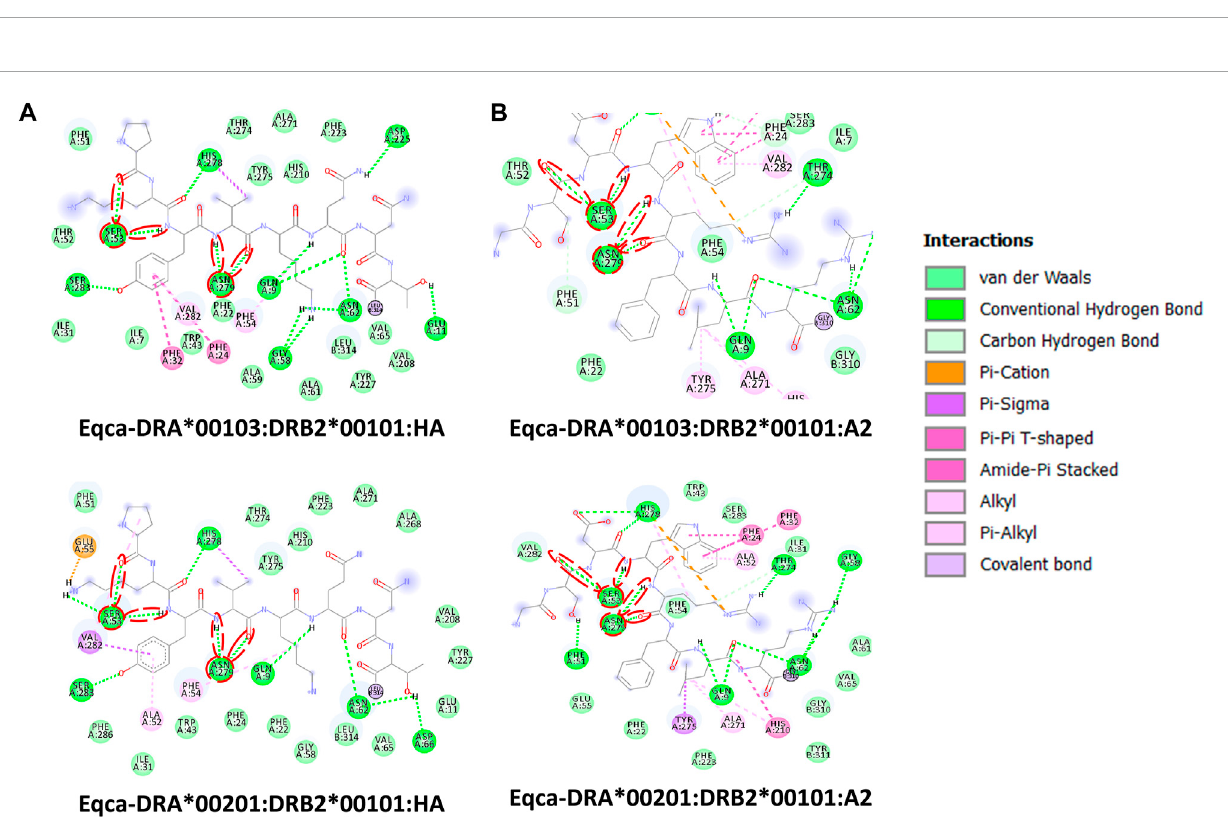
FIGURE 4 Molecular interactive illustration showing the interaction of redocked standard ligands with homology models of the two allelic Eqca-DR. (A) hemagglutinin (HA) and (B) endogenous peptide A2 (A2). 2D chemical structure represents the ligand surrounded by interactive MHCII binding groove residues. P-1, P1 and P2 anchor residues of HA and A2 and their hydrogen bonding interaction with residues of the binding grooves were circled in red. Two allelic Eqca-DR models examined were Eqca-DRA*00103:DRB2*00101 and